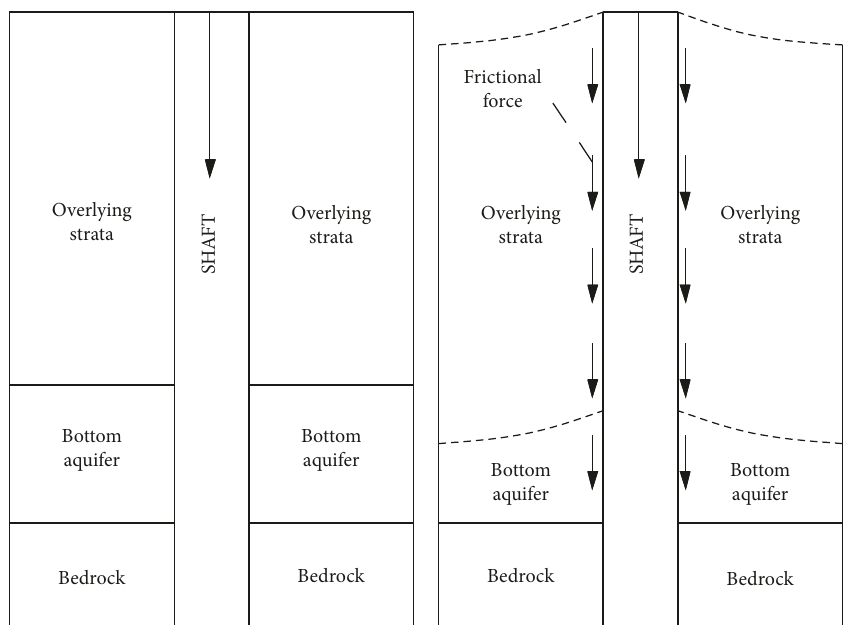
Figure 2: Deformation of the overlying quaternary strata around a shaft: (a) before continuous hydrophobicity at bottom of alluvial aquifer layer; (b) after continuous hydrophobicity at bottom of alluvial aquifer